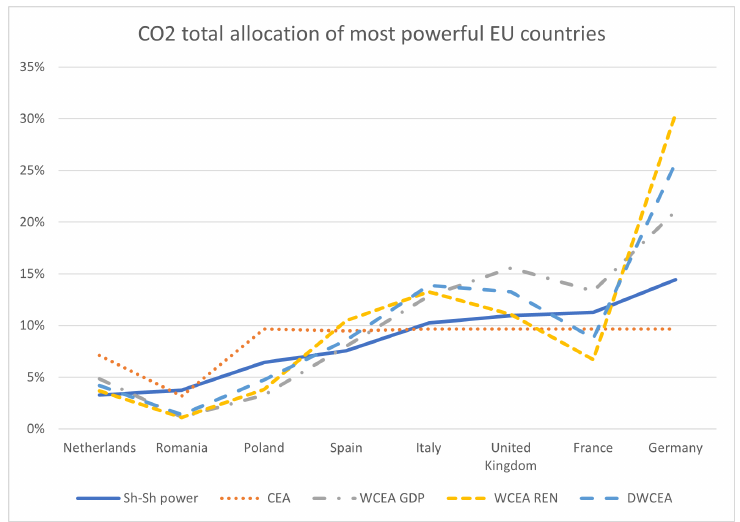
Figure 2. Percentages of total CO 2 emissions permits for the eight most powerful countries (Sh–Sh power index ≥ 3%) for the four allocation rules considered in this paper. Countries are ordered according to the Sh–Sh power index (solid